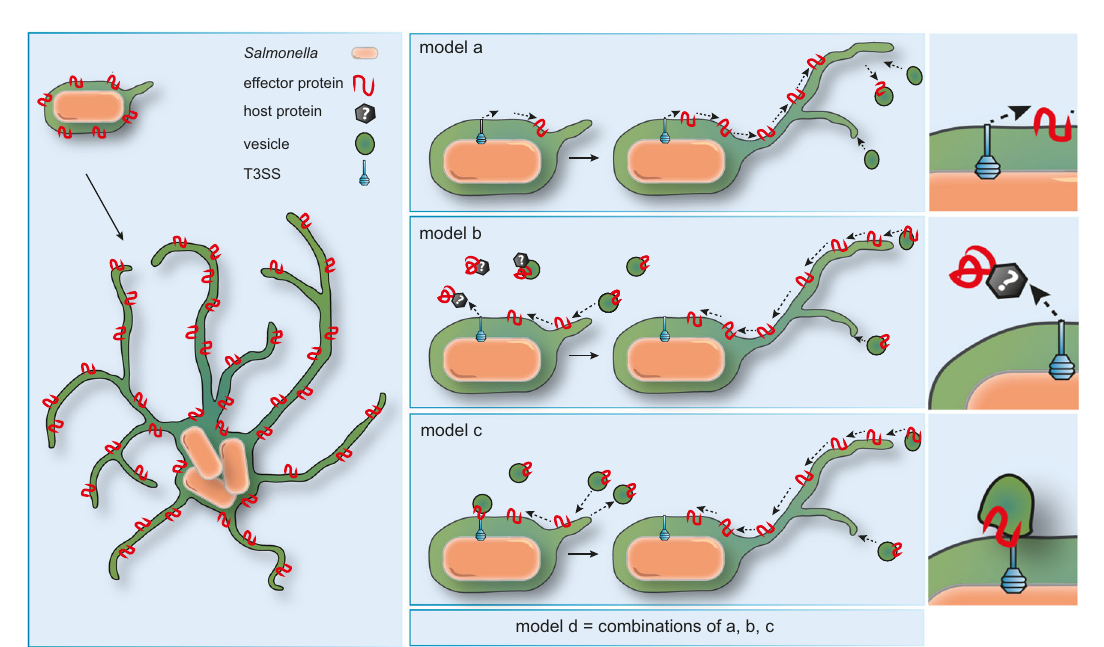
Fig. 3 | Models for targeting of SPI2-T3SS effector proteins to host cell endo- somal membranes. Model a : Effector proteins are directly inserted into the SCV membrane after translocation and diffuse from the SCV to the periphery of SIF. Model b : Effector proteins are translocated into the cytosol, chaperoned, and inserted into endomembranes by unknown host factors. Effector proteins are delivered by fusion of host endosomal vesicles with SIF and SCV. Model c :